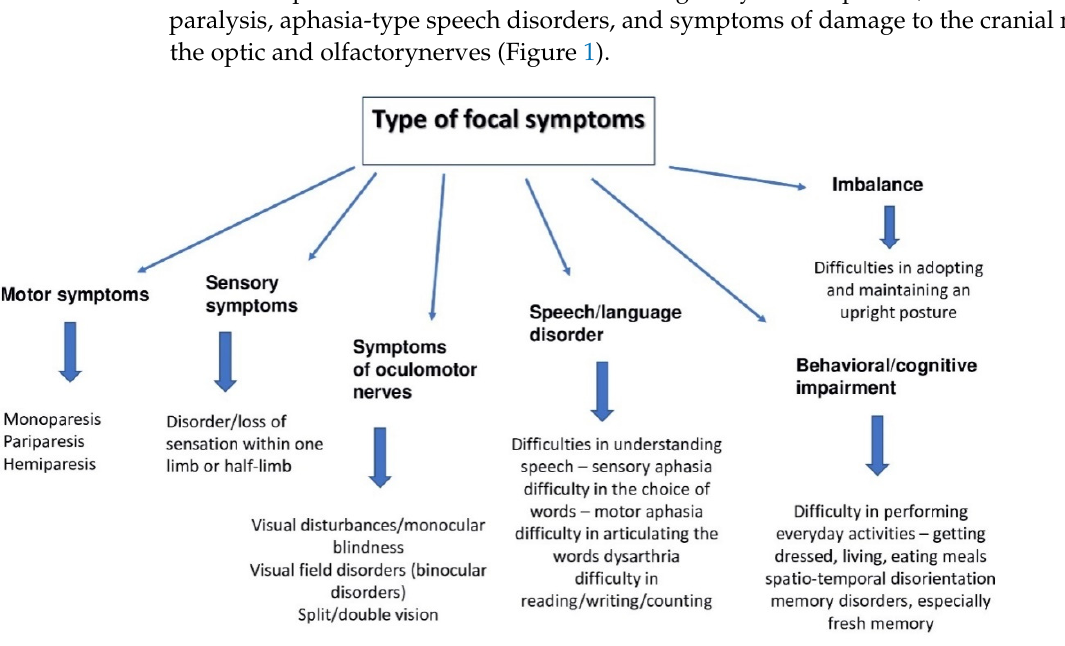
Figure 1. Focal symptoms occurring during subarachnoid hemorrhage.